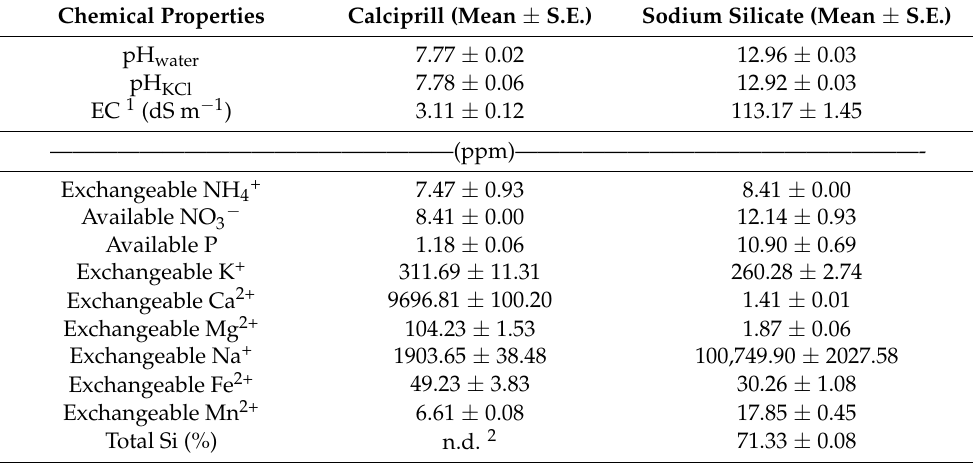
Table 3. Selected chemical properties of Calciprill and sodium